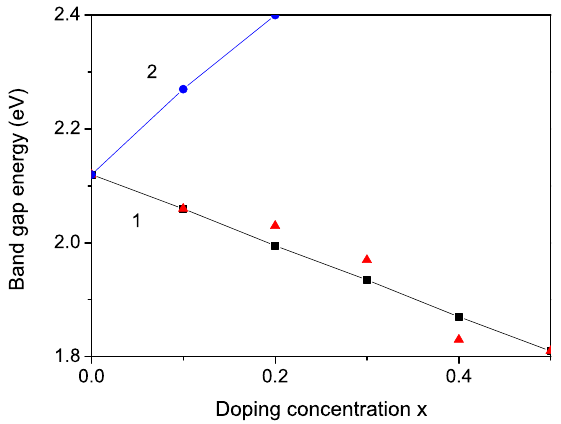
Figure 4. Dependence of the band gap energy E g of a MFO NP with N = 20 shells on different ion doping: (1) Co; (2) La. The red triangles present the experimental data from Ref.